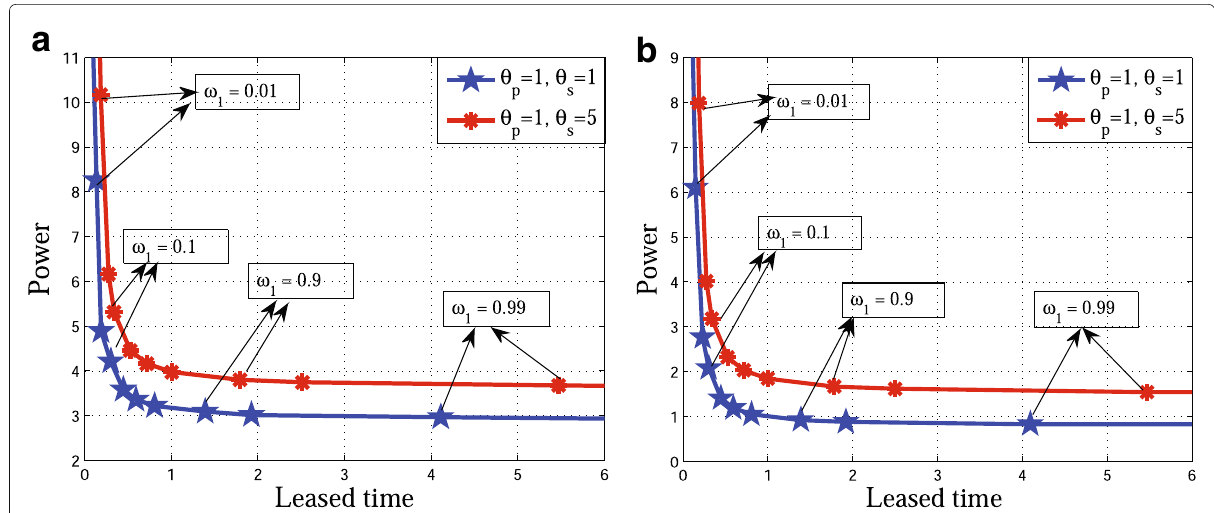
Fig. 1 System design objective tradeoff regions achieved by the proposed optimal resource allocation. a When employing AF relaying protocol. b When employing DF relaying